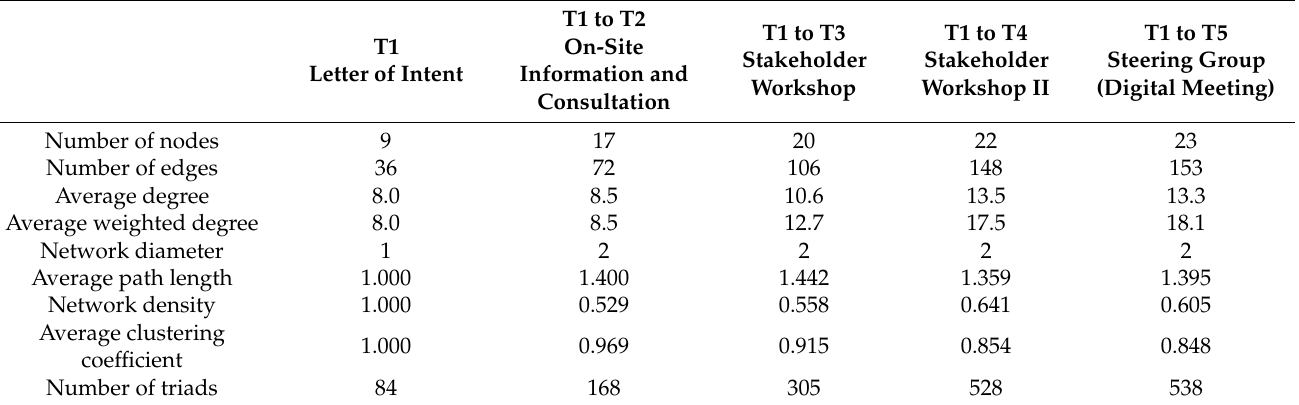
Table 4. Changes of network measures over time (one